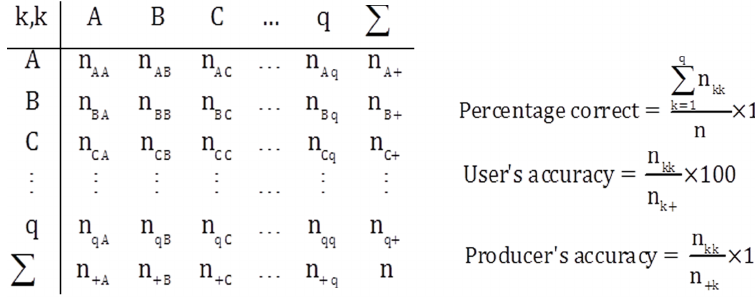
Figure 3. Confusion matrix and percentage correct (overall accuracy), user accuracy and producer accuracy. Table 2. Precipitation stations and availability of